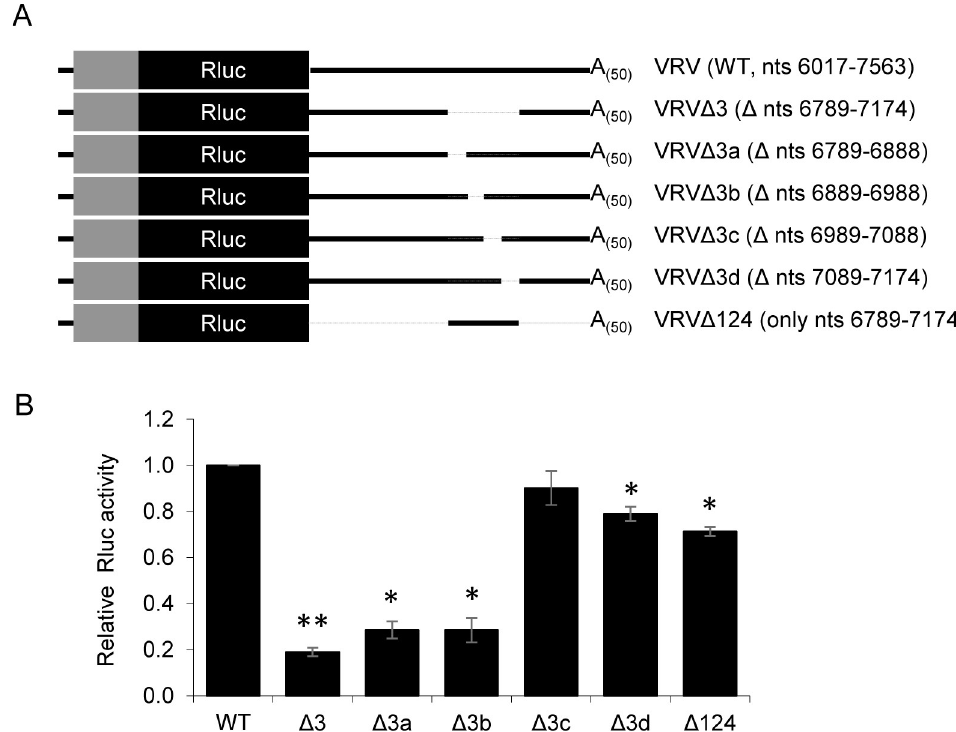
Fig 8. Delineation of sequences required for translation of uncapped VRV transcripts in region 3 of the 3’ UTR. (A) Graphical representation of VRV derivative transcripts containing non-overlapping 100 nts deletions in region 3 of the 3’ UTR. Numbers in parentheses indicate the region of the ToRSV-Rasp1 RNA2 3’ UTR included in the construct (WT and Δ 124) or the regions that were deleted from constructs Δ 3 and Δ 3a to Δ 3d (numbering from the 5’ end of RNA2). (B) Luminescence values from the in vitro translated VRV and deletion derivative transcripts. As shown in Fig 7, deletion of the entire region 3 ( Δ 3) resulted in a significant reduction of translation activity ( �� , < 0.001) (Student’s t-test, two-tailed, n = 2). Translation of the VRV reporter transcript was also significantly decreased upon deletion of the first two 100 nts stretches ( Δ 3a and Δ 3b) in region 3 of the 3’ UTR ( � , P < 0.05) (Student’s t-test, two-tailed, n = 2). The luminescence values from the derivative transcripts are normalized to the value obtained from VRV transcripts and the average of two independent experiments, each with three technical repeats, are shown. Error bars represent the standard